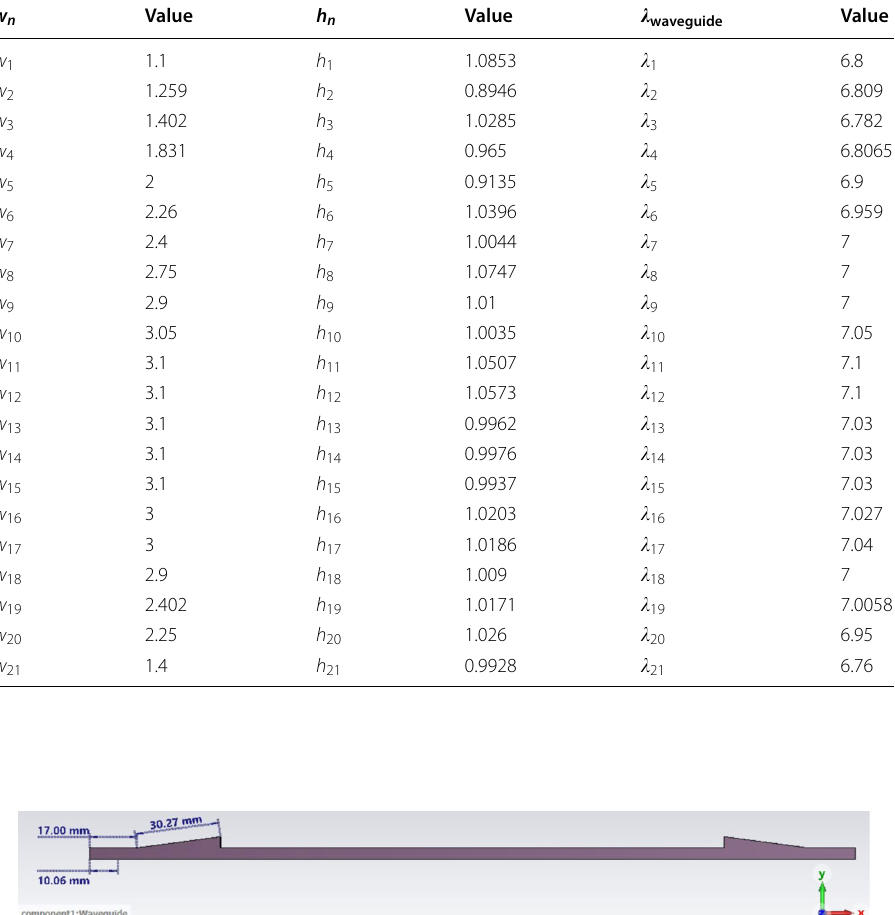
Table 3 The dimensions of irregularities w n and h n , and the calculated local values of the wavelength (cid:31) w n , h n ) for individual radiating element waveguide (